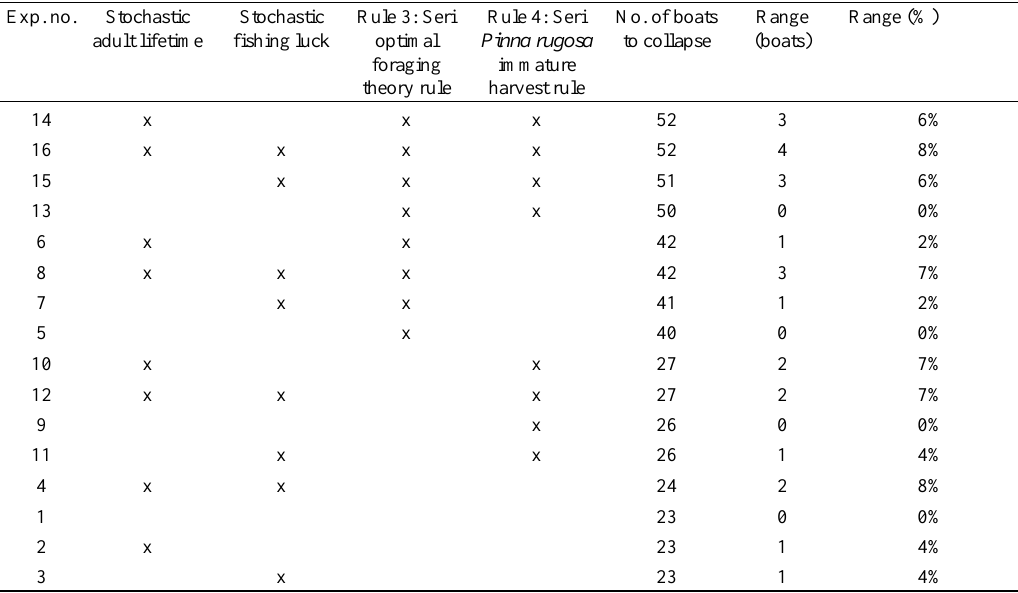
Table 1. Collapse experiments, sorted by collapse threshold. The letter x indicates which stochastic variables and/or institutional rules are active in each experiment. Range represents the difference between the number of boats needed to trigger collapse in one stochastic run and the number of boats needed to trigger collapse in every stochastic run. Exp. no.